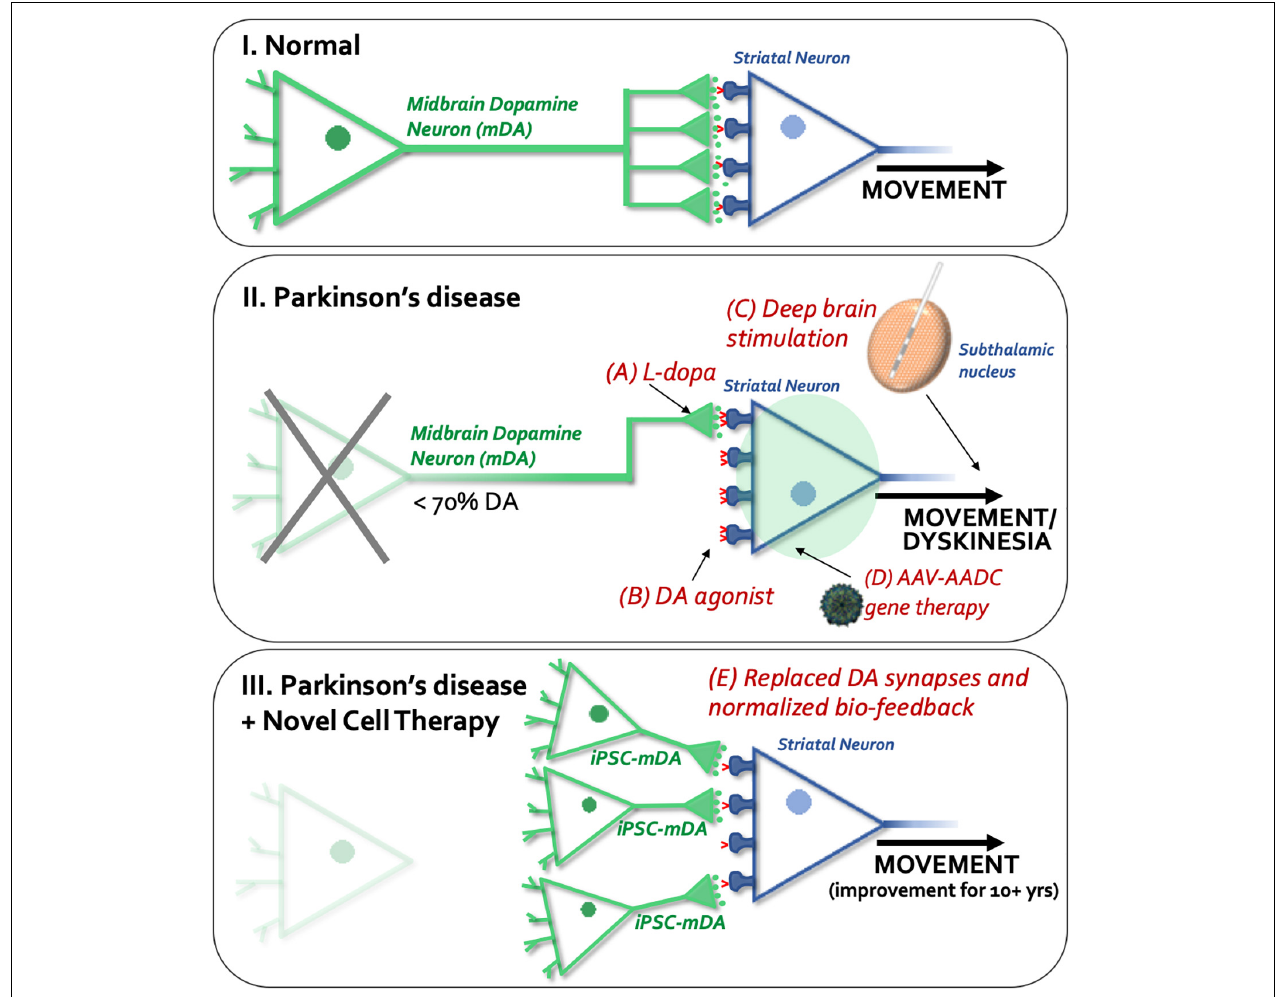
FIGURE 1 | Schematic overview of available or experimental treatments and procedures for Parkinson’s disease. (I) Normal dopaminergic (shown in green) and striatal (shown in blue) synapses, and regulated dopamine (DA) release and reuptake (dopamine transporters shown in red) in the normal brain. (II) Shows current and experimental treatments: A, L-dopa; B, dopamine agonists; C) Deep brain stimulation (DBS), and D, gene therapy. The unique aspect of cell therapy (see III , E) is that it restores physiological dopamine release by synapses provided through new neurons implanted into the